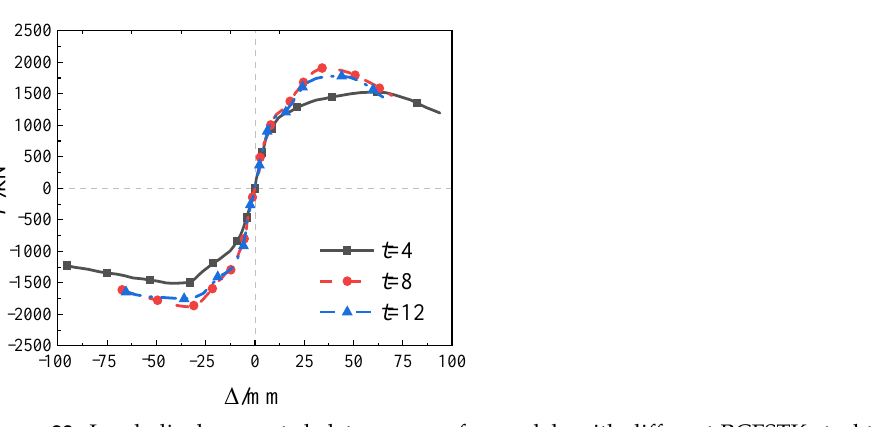
Q235 Q390 Q420 Figure 25. Load – displacement skeleton curve of models with different RCFSTK steel strengths. Figure 25 and Table 9 show that the load – displacement skeleton curves of the speci- mens differed slightly. When the RCFSTK steel strength increased from Q235 to Q420, the yield load, ultimate load, failure load, and initial stiffness of the models increased by 12.1%, 8.4%, 8.4%, and 4.1%, respectively. The displacement ductility ratio and energy dissipation coefficients decreased by 12.5% and 9.0%. The principal reason for these changes is that the RCFSTKs are mainly subjected to shear deformation and increasing steel strength can increase RCFSTK resistance to shear stress and thus decrease defor- mation. Overall, the change in the steel strength of the RCFSTKs has little effect on the